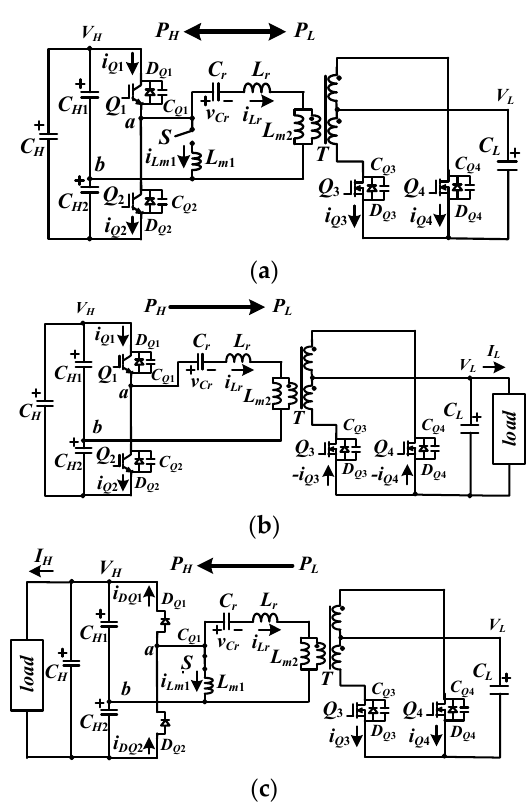
Figure 1. Circuit diagram of conventional resonant converter with ( a ) center-tapped rectifier on the secondary-side ( b ) with synchronous rectifier on the secondary-side.